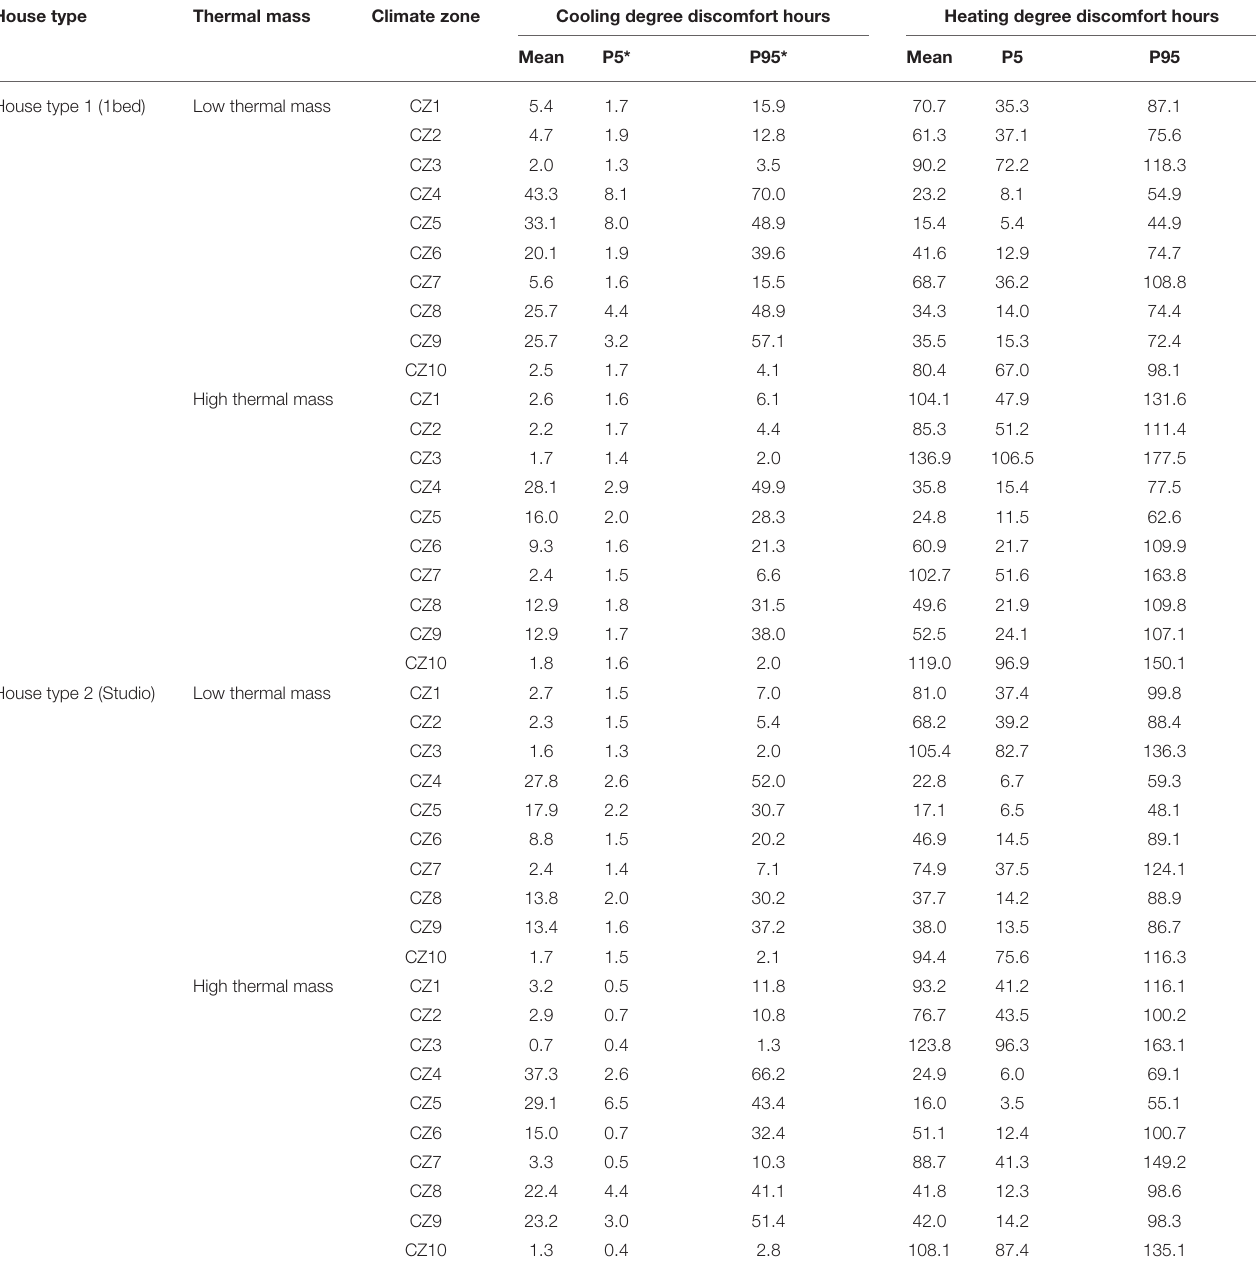
TABLE 2 | Statistics of mean daily cooling and heating degree discomfort hours for each house type. House